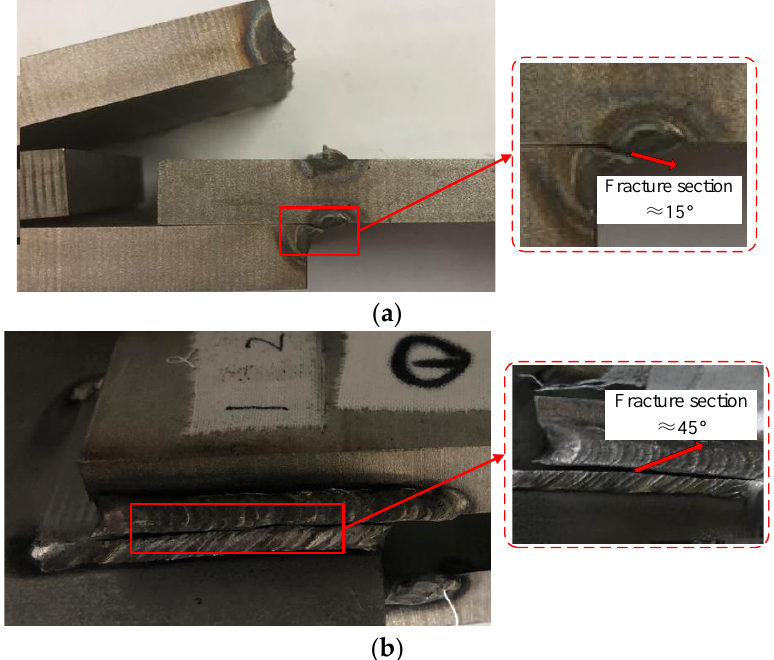
Figure 3. Failure fractures of the welded joints: ( a ) transverse welded specimen; ( b ) longitudinal welded specimen.